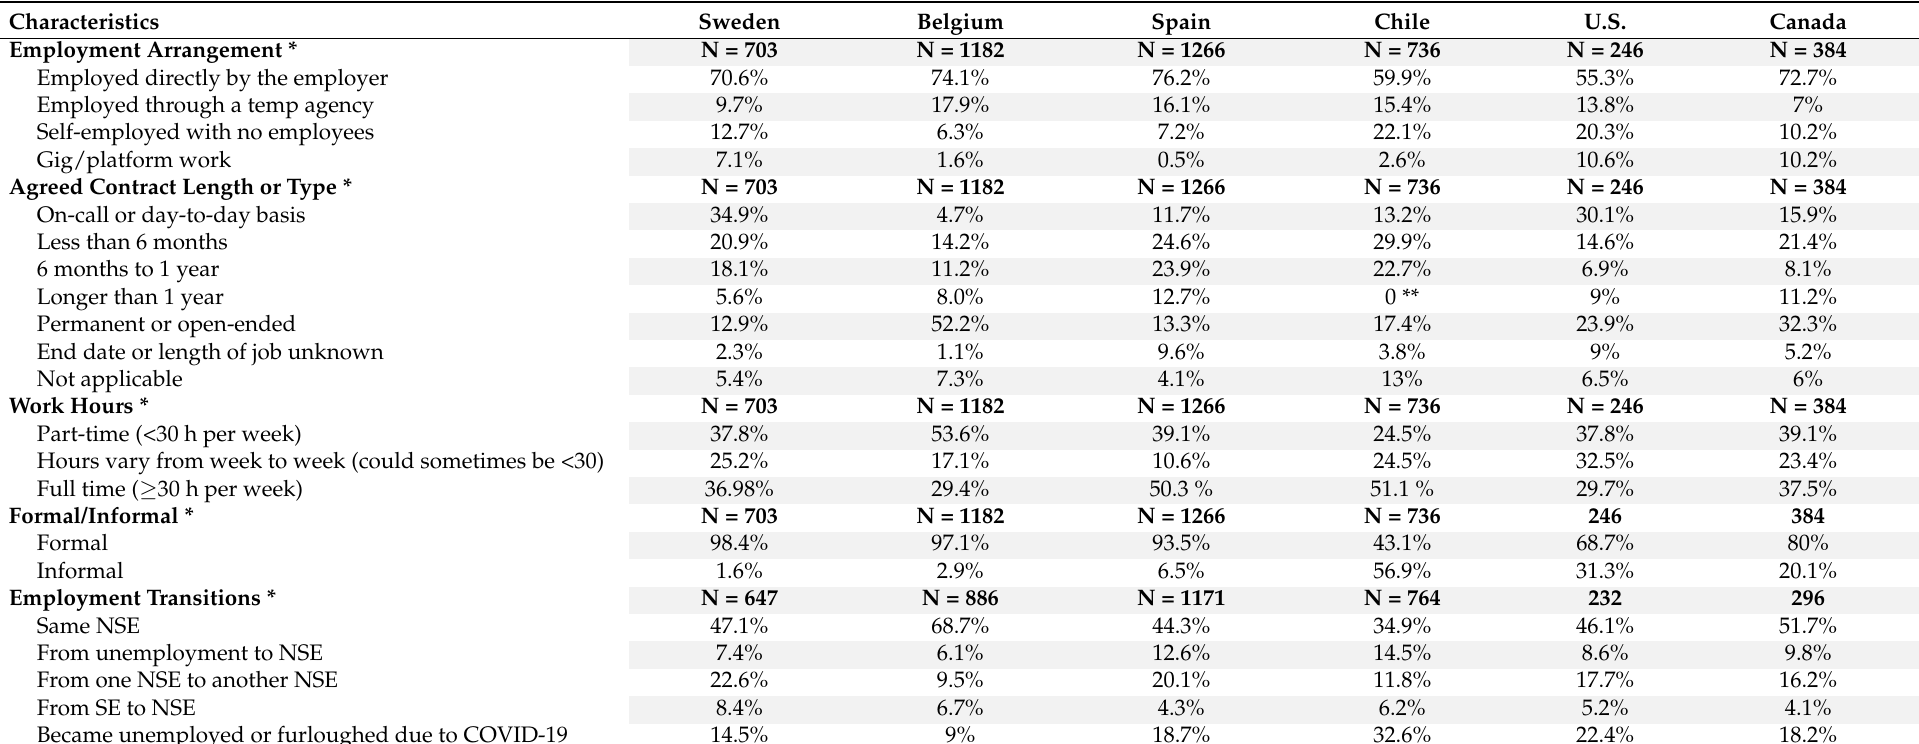
Table 3. Employment characteristics and employment transitions of the convenience purposive samples across the six